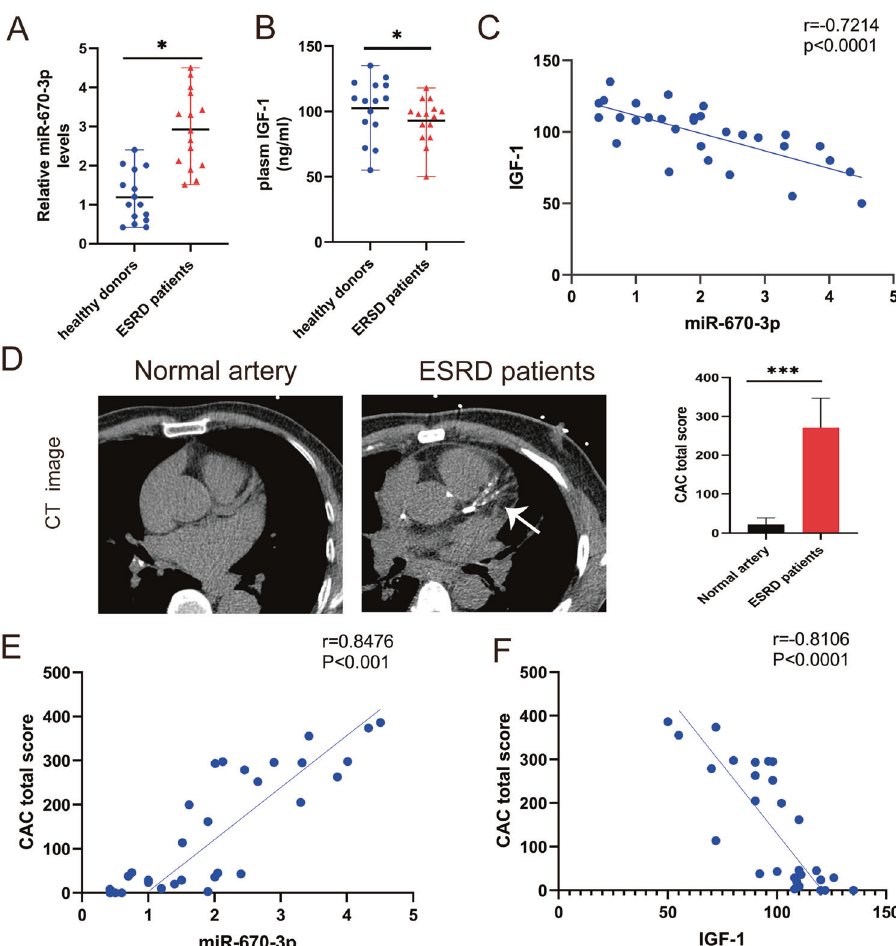
Fig. 7 Circulating exosomal miR-670-3p was correlated with artery calci fi cation in patients with ESRD. A qRT-PCR detection of miR-670-3p levels in plasma exosomes of healthy controls and patients with ESRD ( n = 15). B The level of IGF-1 in the plasma of healthy people and patients with ESRD was measured by ELISA ( n = 15). C Analysis of linear correlation between exosomal miR-670-3p and IGF-1 in plasma. D Analysis of coronary vascular calci fi cation scores of normal people and patients with ESRD by multilayer spiral CT reconstruction, and representative pictures were shown ( n = 15, left panel). The quanti fi cation results of CAC score in normal people and patients with ESRD (right panel). E Analysis of Spearman correlation between exosomal miR-670-3p and CAC score. F Analysis of Spearman correlation between plasma IGF-1 and CAC score. One-way ANOVA with Bonferroni ’ s post hoc test ( A , B ) and Spearman ’ s r test ( C , E , F ) were used. Data represented the mean ± SD. * p <